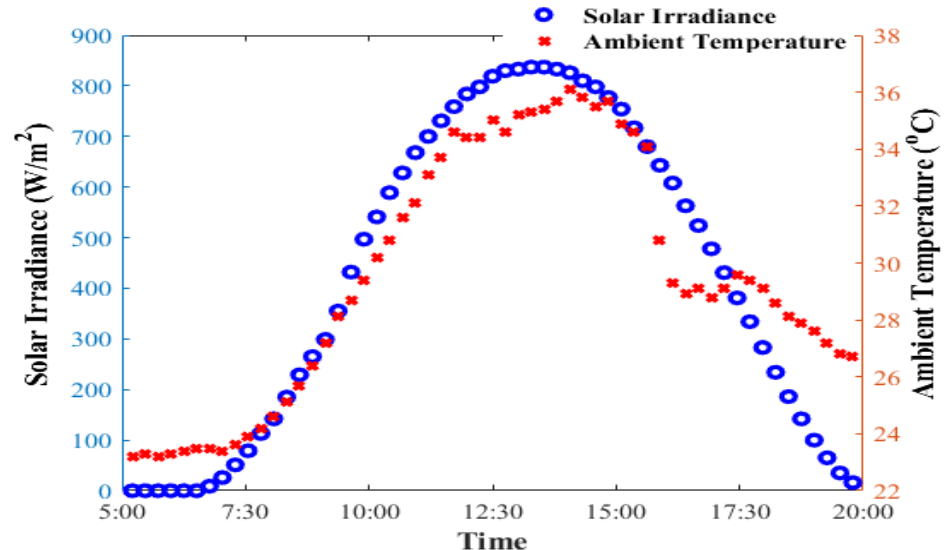
Figure 7. Measured solar irradiance and ambient temperature.